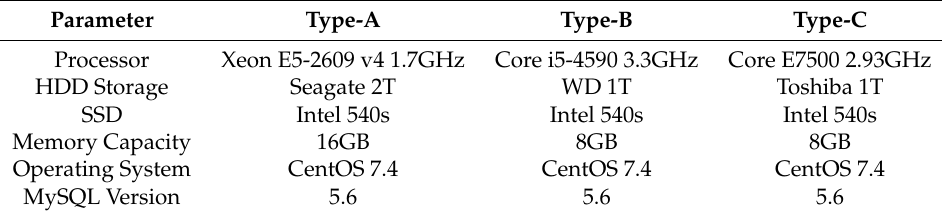
Table 6. Detail Configuration of Experimental